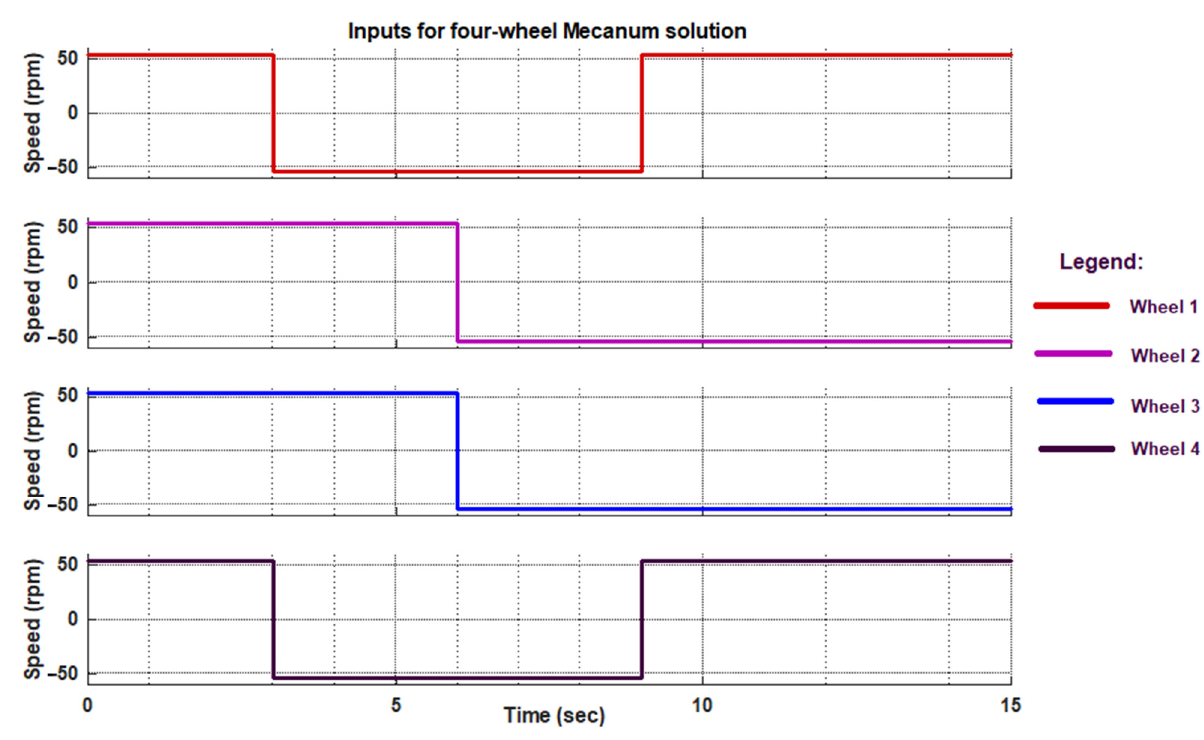
Figure 8. Inputs for the four-wheel Mecanum kinematic solution (speed of the wheels).